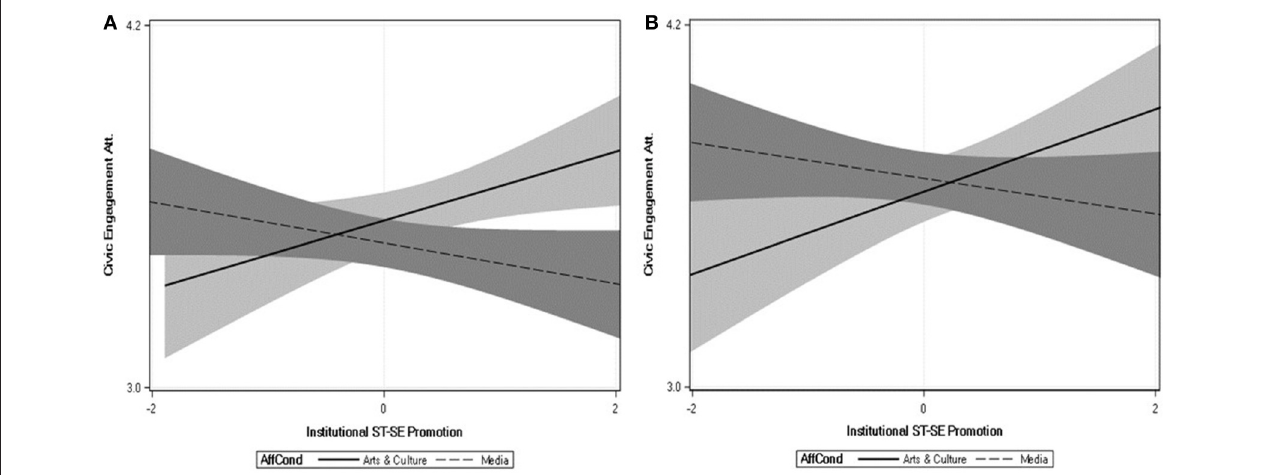
FIGURE 1 | Relations between civic engagement attitudes (y axis) and the extent to which the institutions of Arts and Culture and Media are perceived to promote relatively more self-transcendence vs. self-enhancement values (x axis) in the UK (A) and the US (B) . Shaded regions reflect the 95% confidence regions around the regression lines.